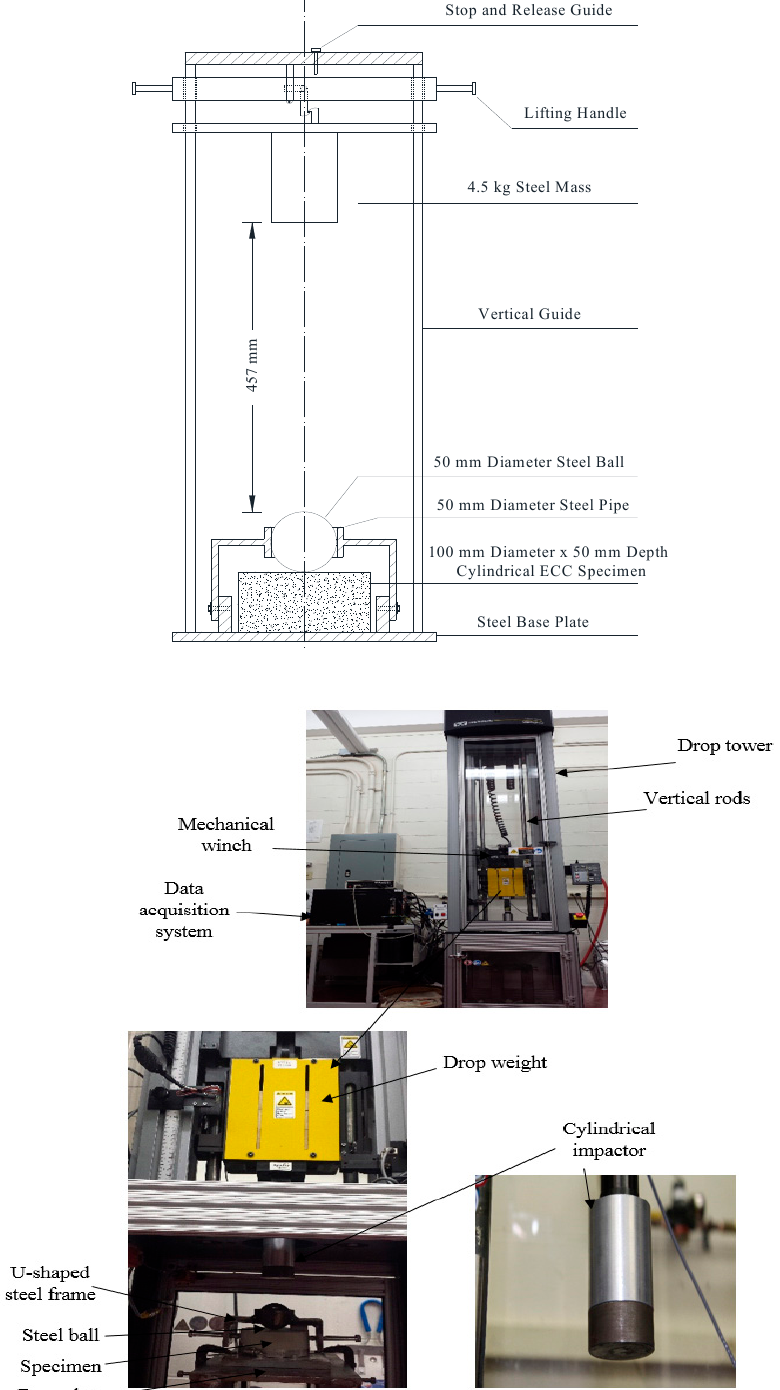
Figure 4. Schematic diagram and photographs of the drop weight impact testing system, showing the drop weight, arrangement for specimen support, and cylindrical impactor.